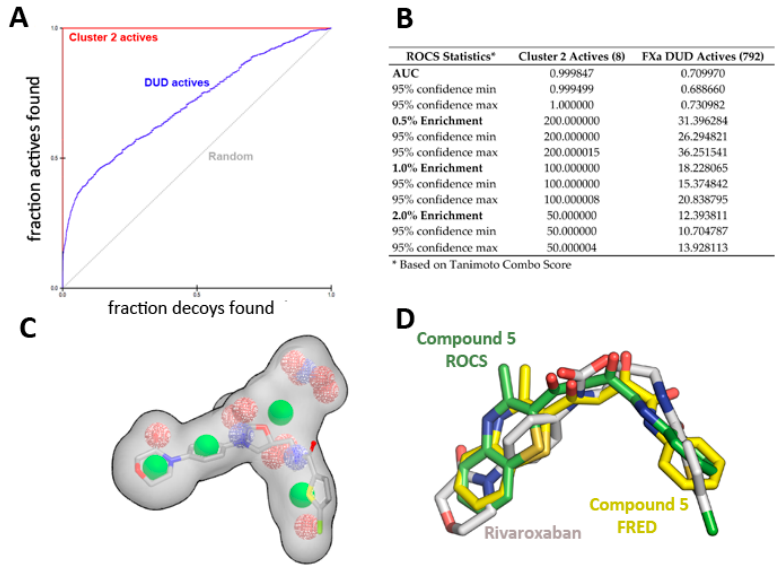
Figure 6. ROCS shape-based query validation statistics for Cluster 2. ( A ) ROC plot and ( B ) validation statistics using the active ligands of cluster 2 or the FXa actives from the DUD-E database. ( C ) Superposition of Rivaroxaban over the cluster 2 shape-based query, and ( D ) Comparison of crystallographic position of Rivaroxaban (PDB id 2W26) with the position obtained for compound 5 with ROCS and FRED runs.